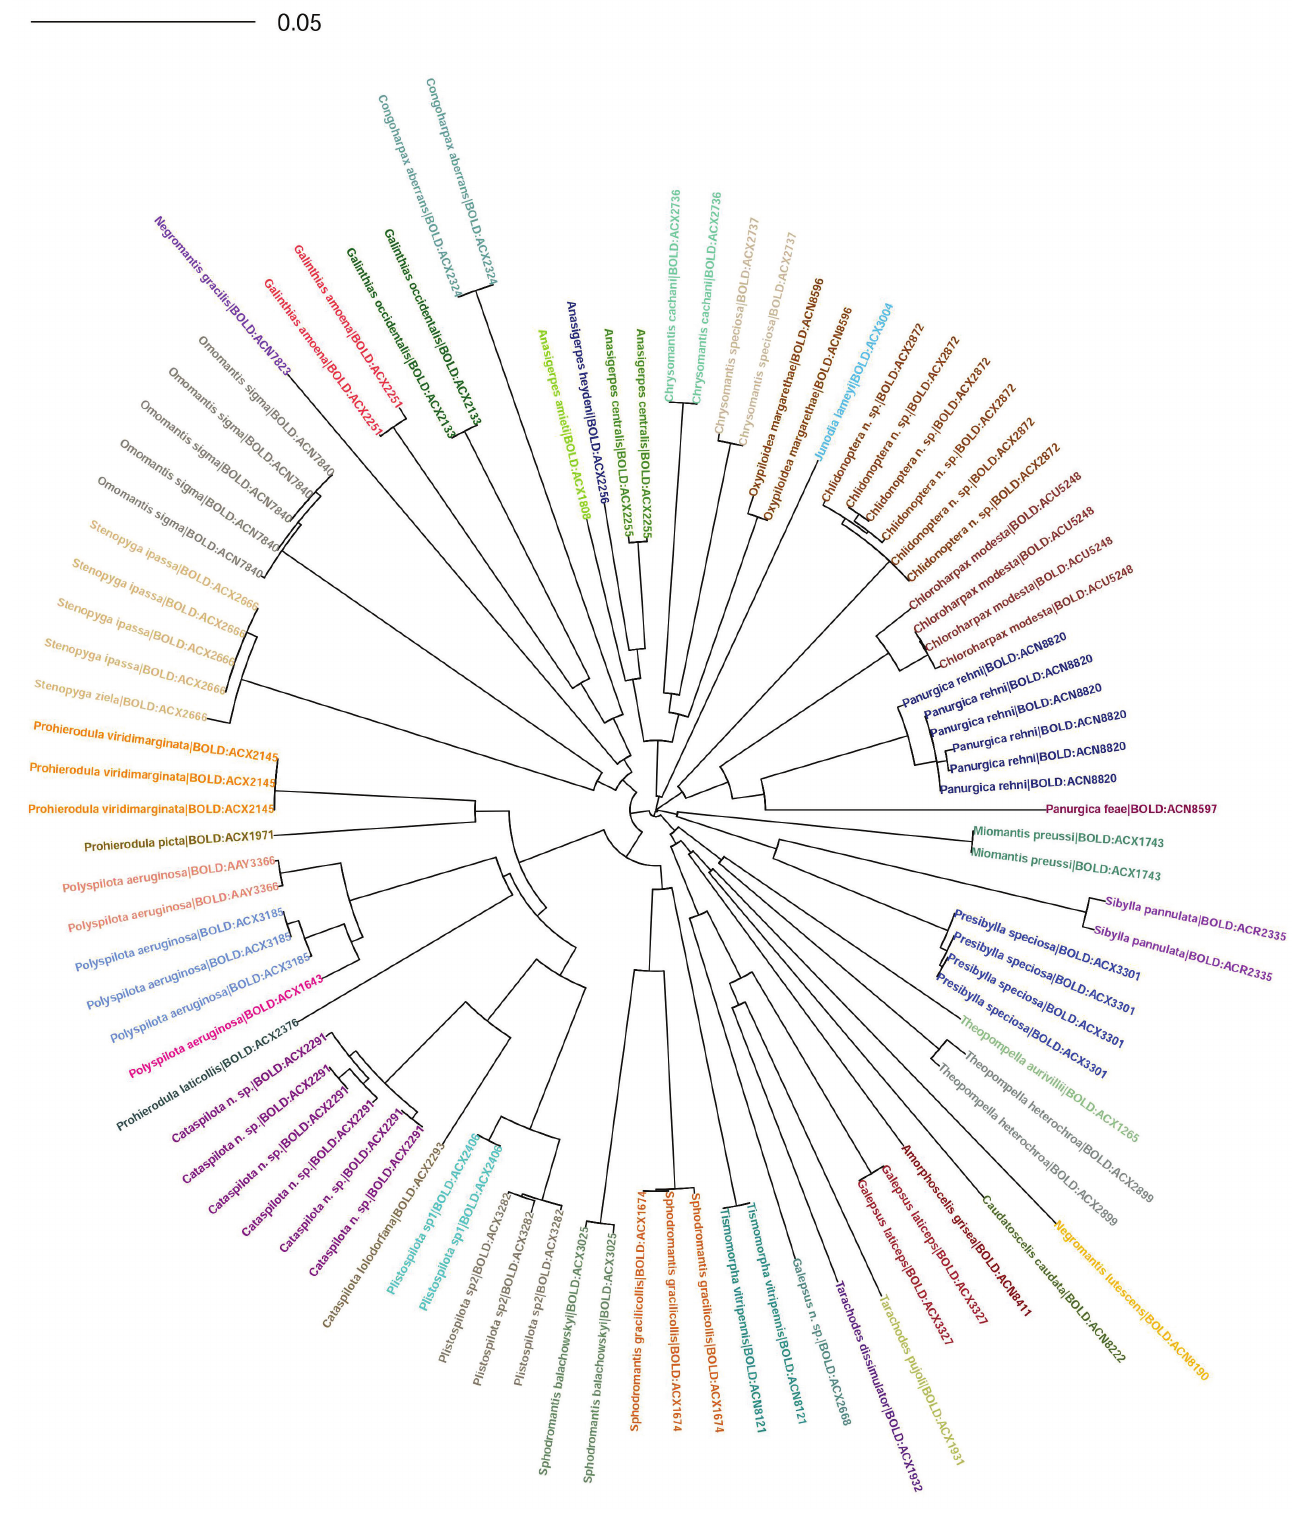
Fig. 8. Neighbor-joining tree of DNA barcodes (COI) obtained from BOLD 4.0. beta using the Kimura 2 parameter for distance model. Filters: sequence length > 200